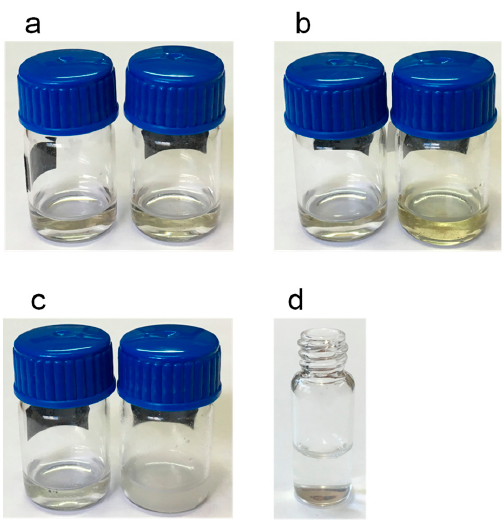
Figure 3. Images of the extracts obtained after adding 1 mL of methanol: ( a ) white copal, ( b ) ocote and ( c ) copal in tears; left vials in ( a – c ), 1 mg of samples; right vials in ( a – c ), 15 mg of the samples. ( d ) solution obtained after treating the residue insoluble in methanol of copal in tears (10 mg) with 1 mL of water. For other experimental details, see the text. Table 2. Recoveries * obtained from the spiked extracts ( n =